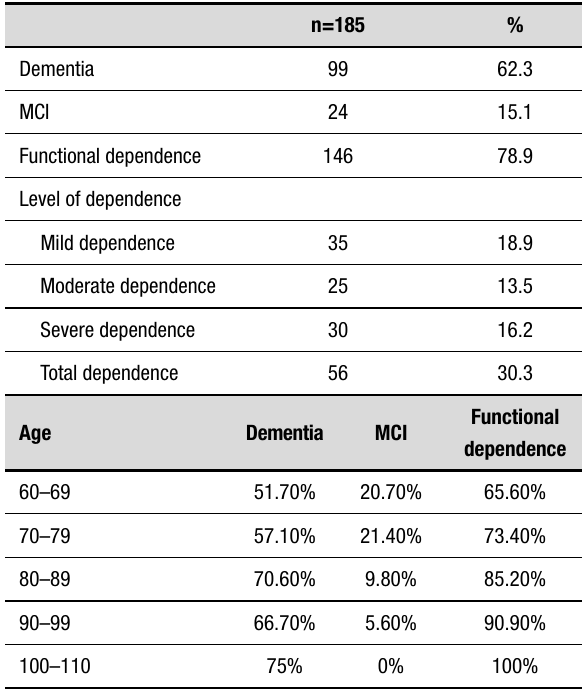
Table 2. Absolute and relative prevalence of dementia, mild cognitive impairment, and functional dependence.